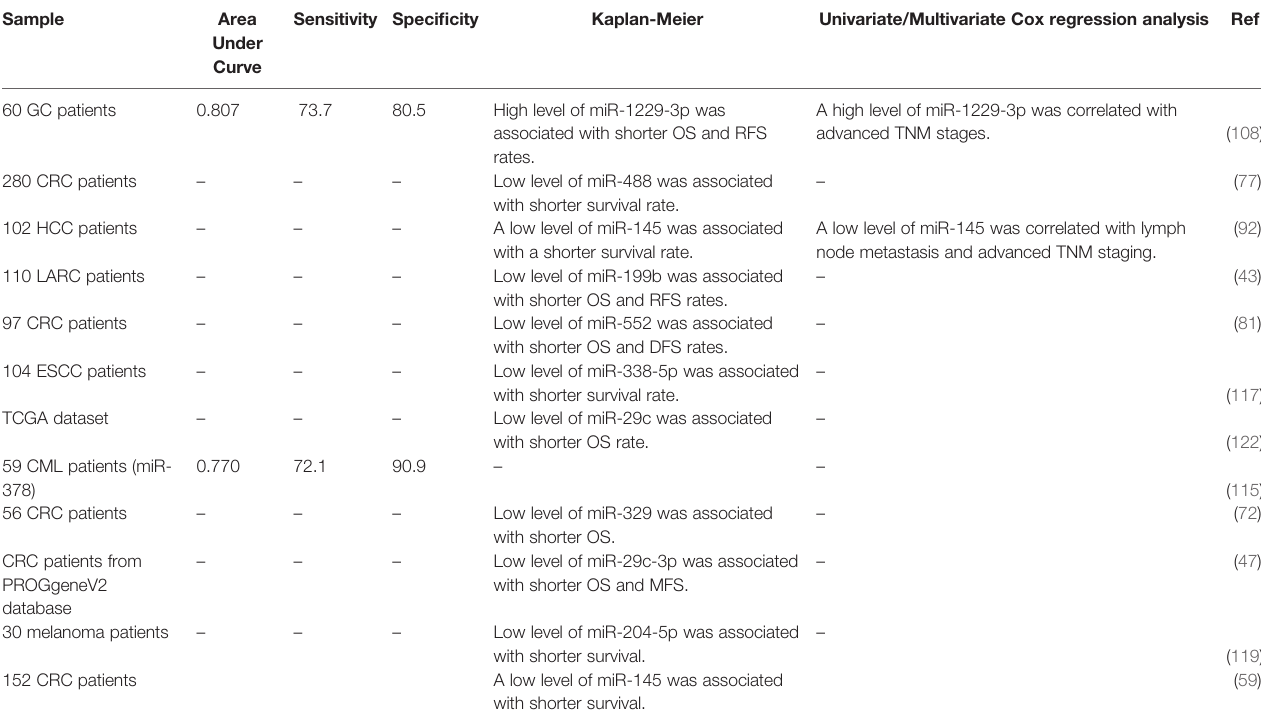
TABLE 5 | Diagnostic/prognostic roles of 5-FU-related miRNAs (OS, overall survival; RFS, relapse-free survival; DFS, disease-free survival).